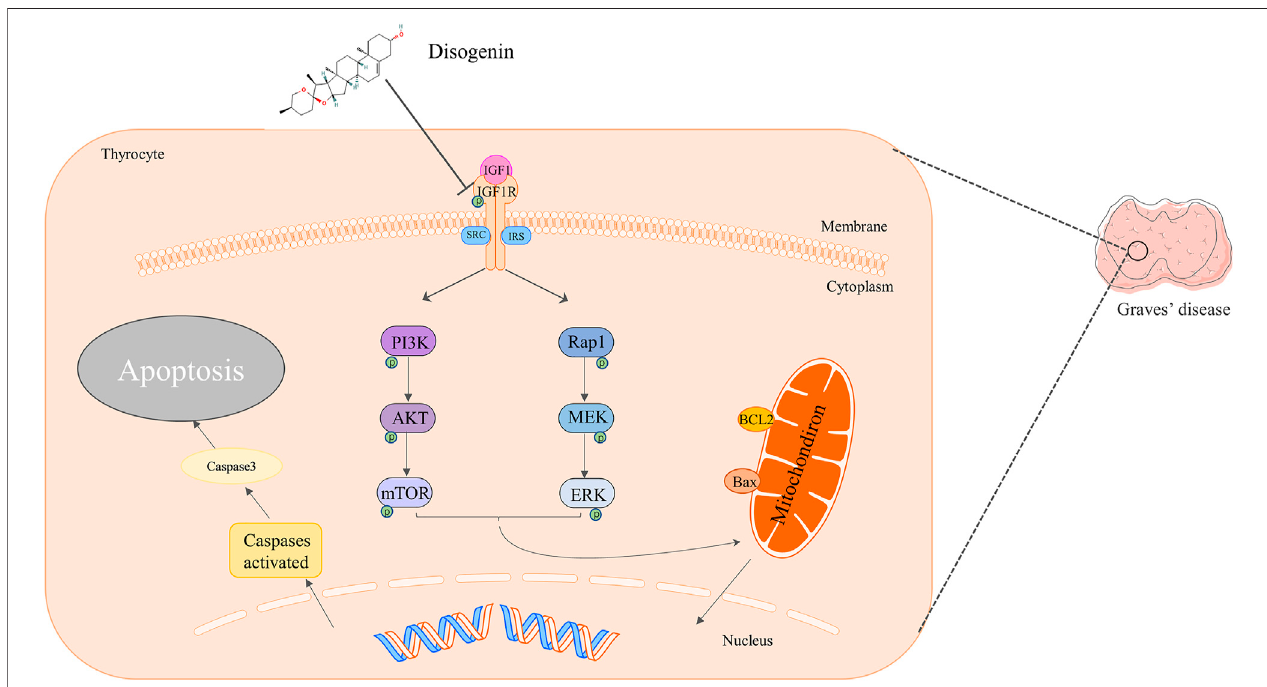
FIGURE 10 | Mechanism of diosgenin in the treatment of Graves ’